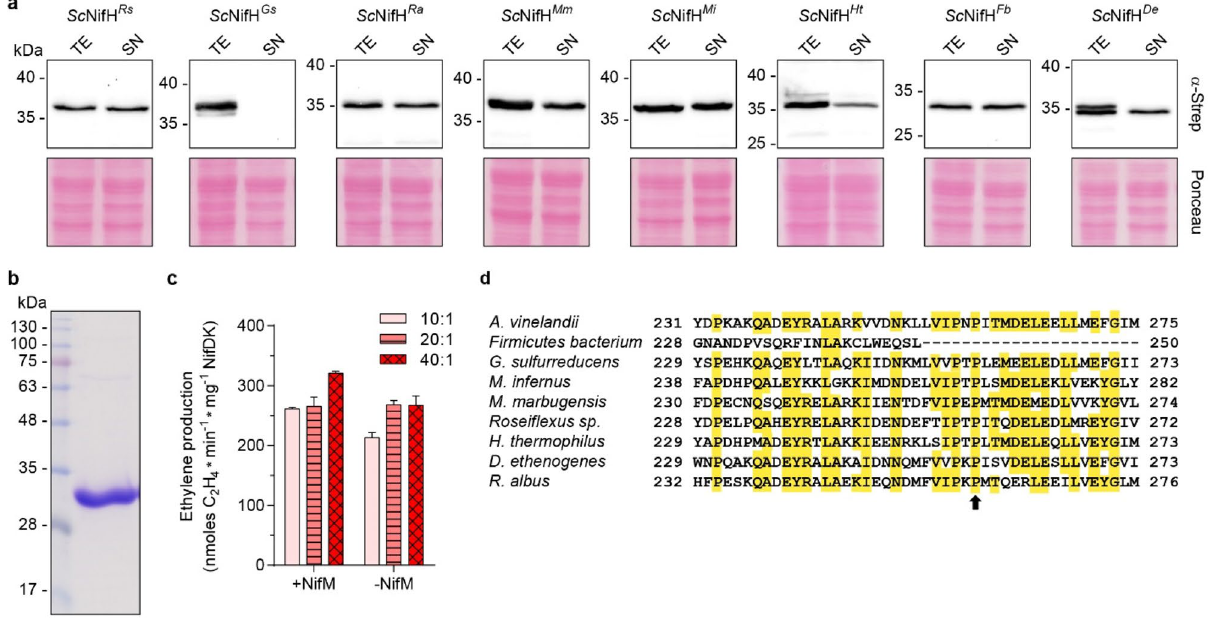
Figure 6. Effect of NifM Av on Sc NifH Xx solubility and functionality. (a) Immunoblot analysis of the levels of Sc NifH Xx variants in total yeast extracts (TE) and the soluble fractions (SN) when expressed in the absence of NifM Av . The uncropped immunoblots and membranes are shown in Fig. S12. (b) Sc NifH De isolated from yeast cells not expressing NifM Av . The uncropped Coomassie stained gel is shown in Fig. S13. (c) Comparison of the specific activity of Sc NifH De isolated from yeast cells expressing (+ NifM) or not expressing NifM (− NifM) using ARA. The molar ratio of Sc NifH De to NifDK Av is indicated. Mean and SD is shown. n = 2 technical replicates. (d) Alignment of NifH Av with the eight Sc NifH Xx variants analyzed in ( a ). The C-terminal domain containing Pro 259 in NifH Av (indicated by a black arrow) proposed to be the target of NifM action is shown. The full sequence alignment can be found in Supplementary Fig.